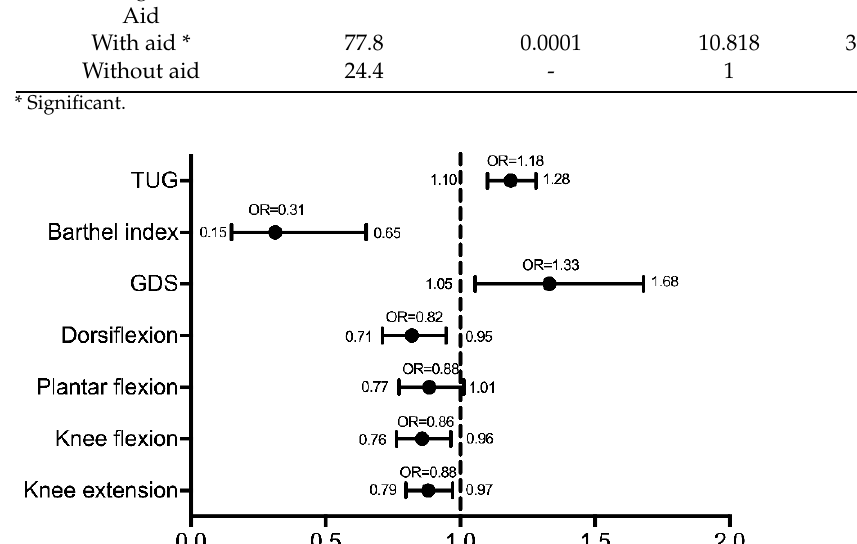
Figure 1. Odds ratio with 95% CI for different variables affecting balance.